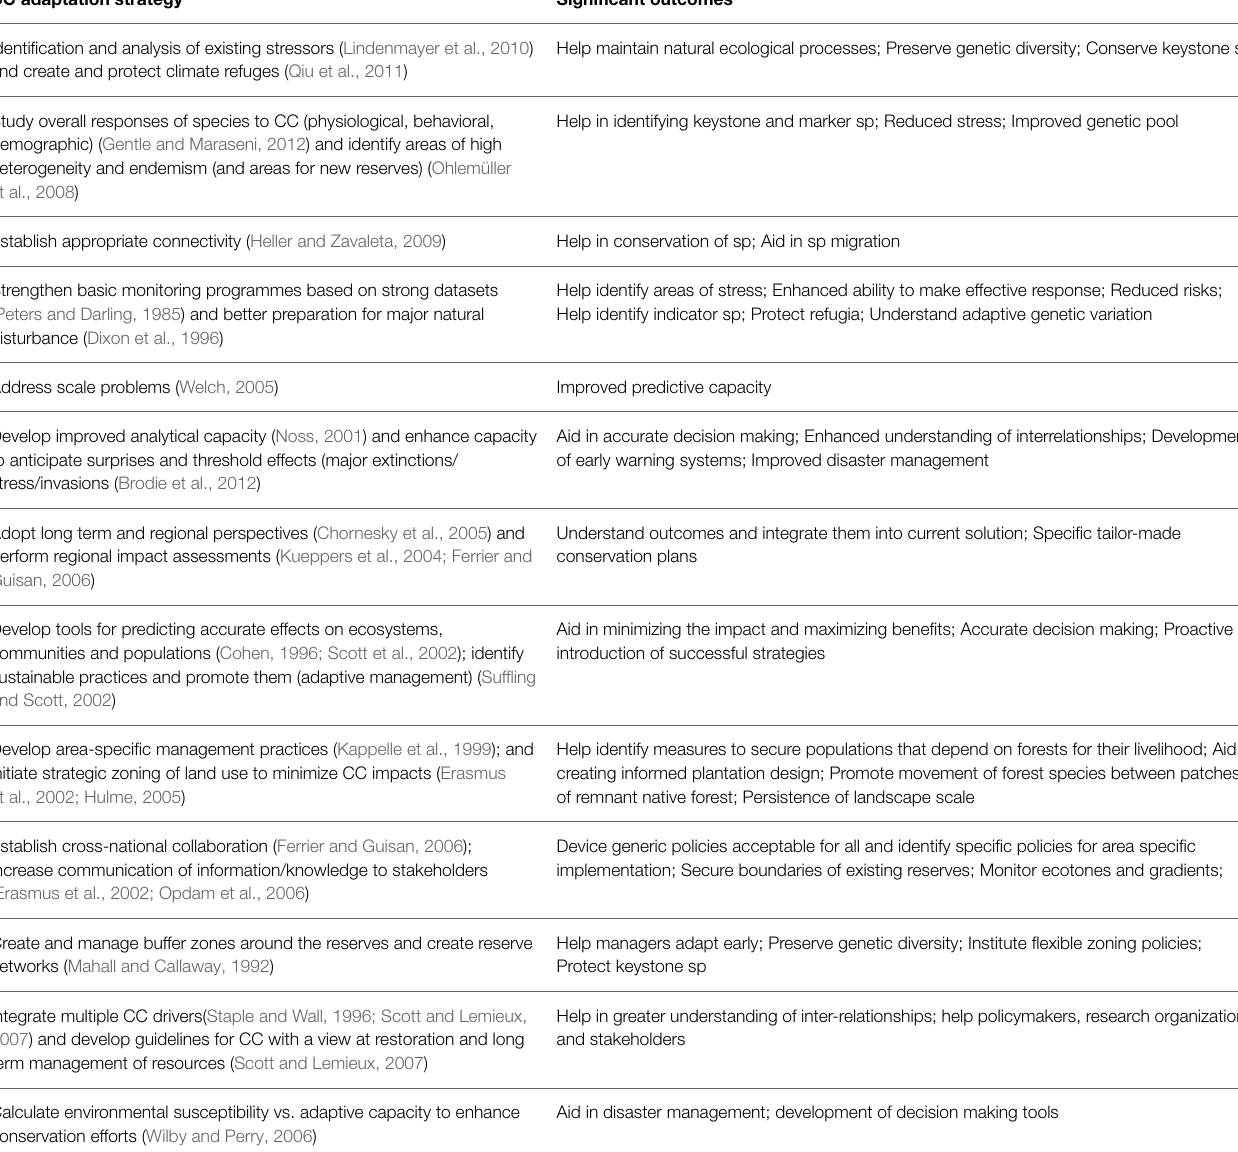
TABLE 1 | Important CC adaptation strategies for biodiversity conservation and their significant